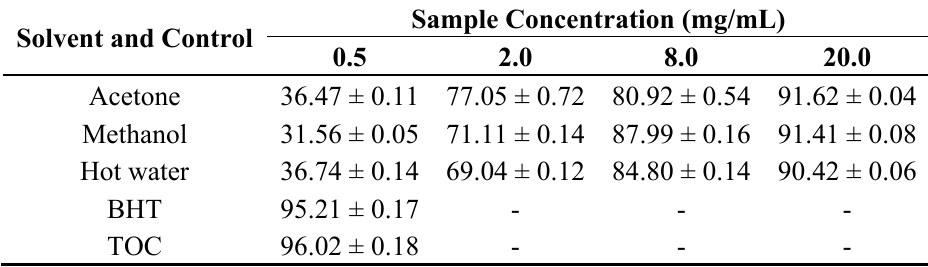
Table 1. Antioxidant activity against β -carotene-linoleic acid of different concentrations of various extracts from the fruiting bodies of Pleurotus florida .